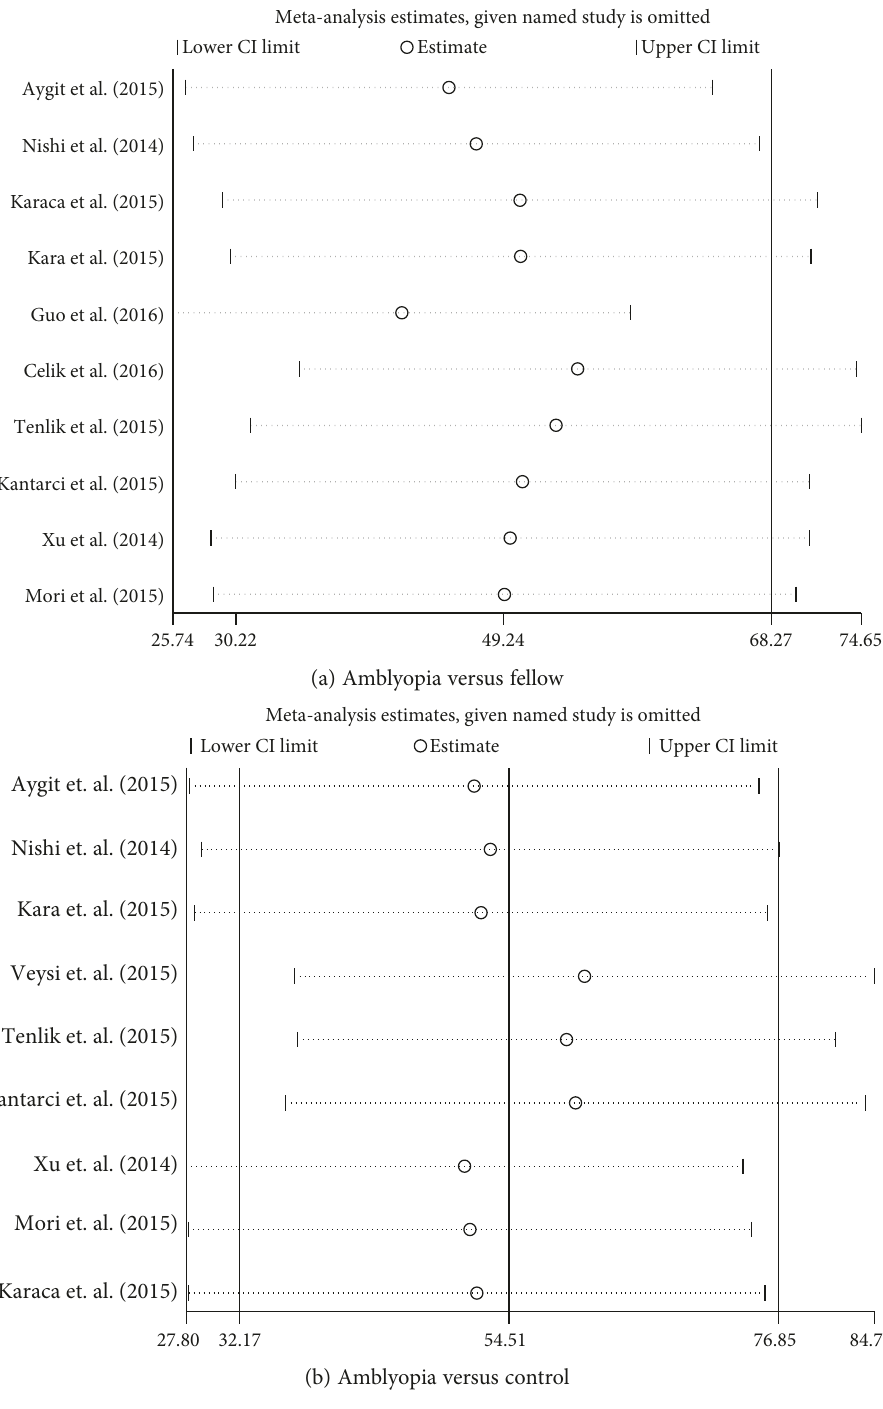
Figure 3: Sensitivity analysis of meta-analysis. (a) The amblyopic eye versus the fellow eye. (b) The amblyopic eye versus the control eye. When one study is deleted at a time, the corresponding estimates do not change signi fi